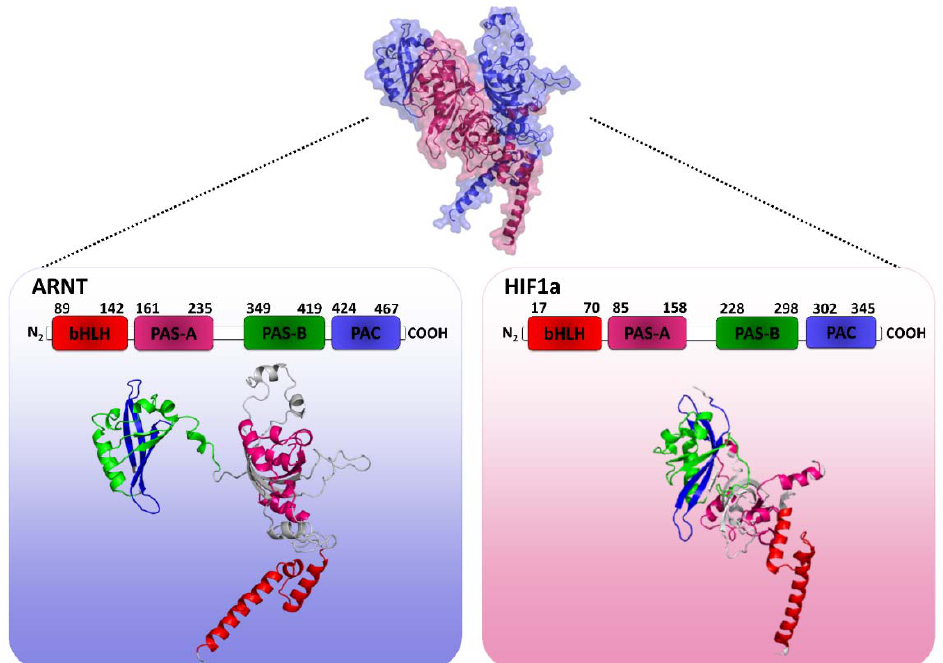
Figure 1. 3D representation of the human HIF1 quaternary structure modeling (HIF1a-ARNT complex). Chain A is highlighted in reference to β subunit (ARNT) in blue and chain B is highlighted in reference to α subunit (HIF1a) in pink. Boxes are the structures of each separate chain with illustrated protein domains. Note: Author’s own